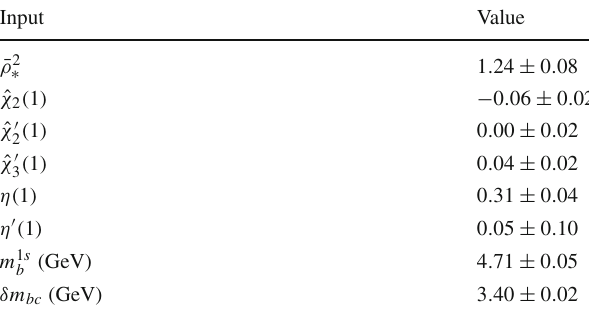
Table 17 Inputs used in the evaluation of the HQET form